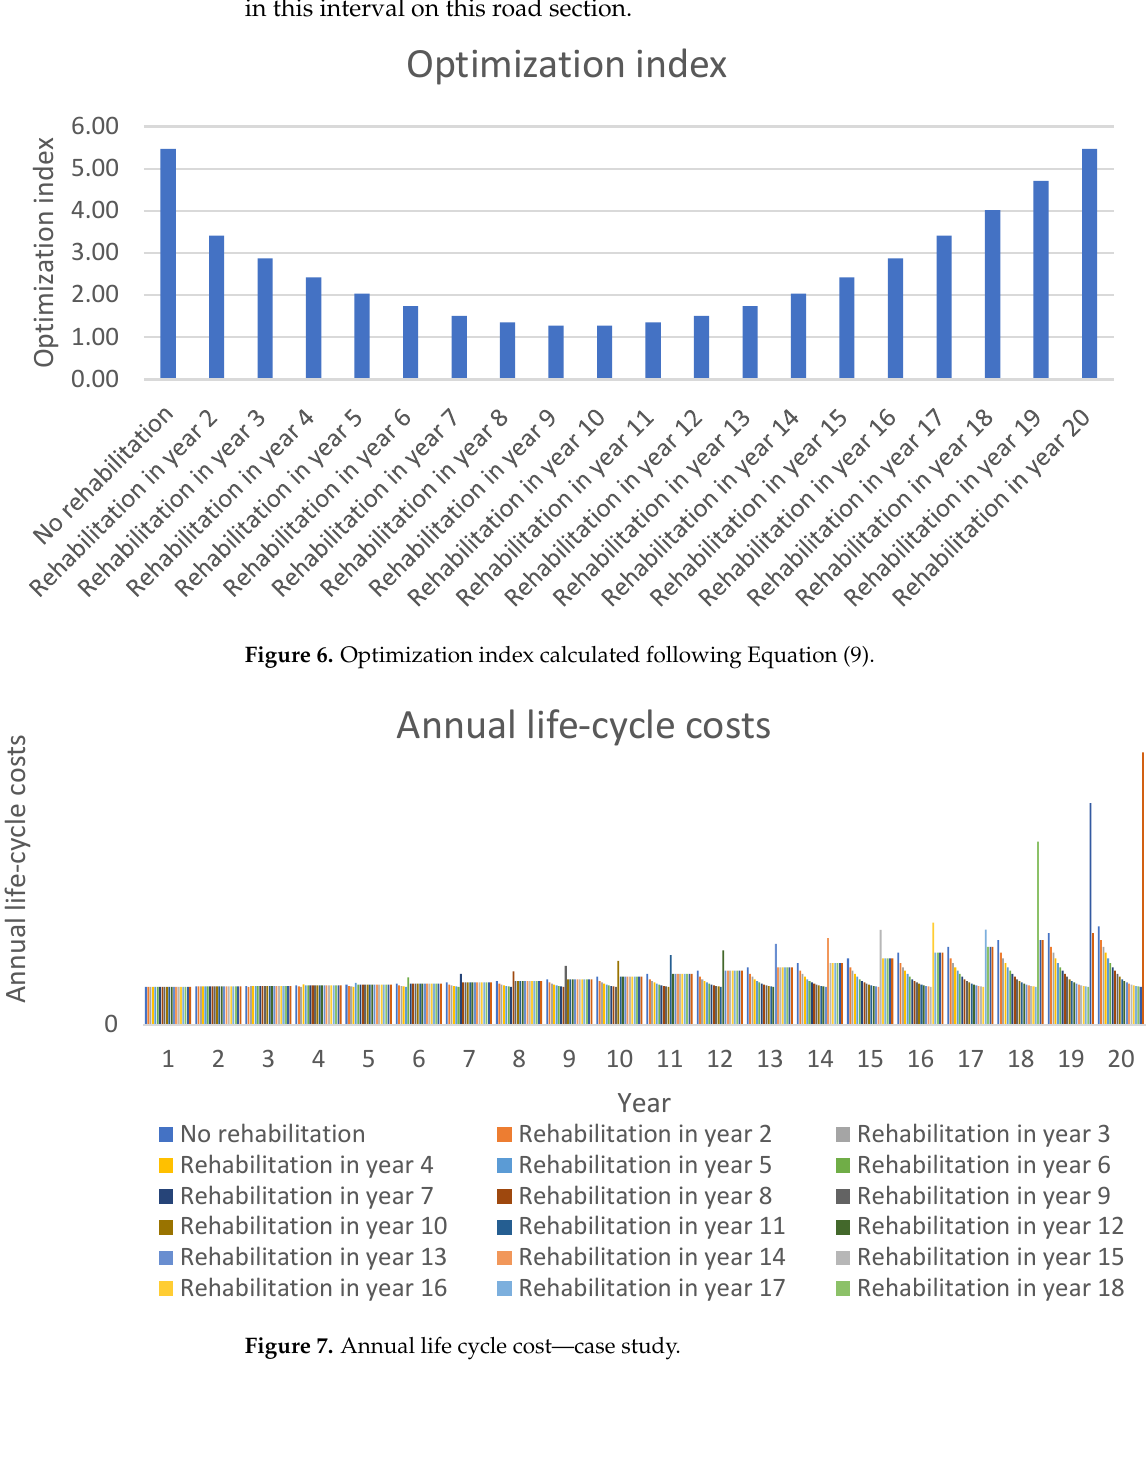
Figure 5. Pavement serviceability — case study.